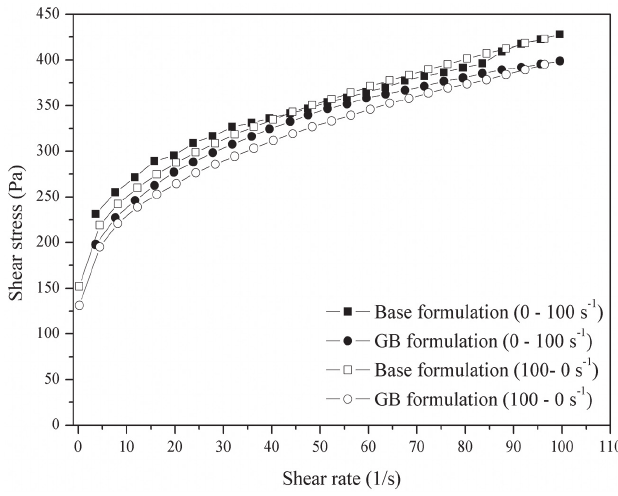
FIGURE 2 - Flow curve of the formulations containing or not the GB soft extract.